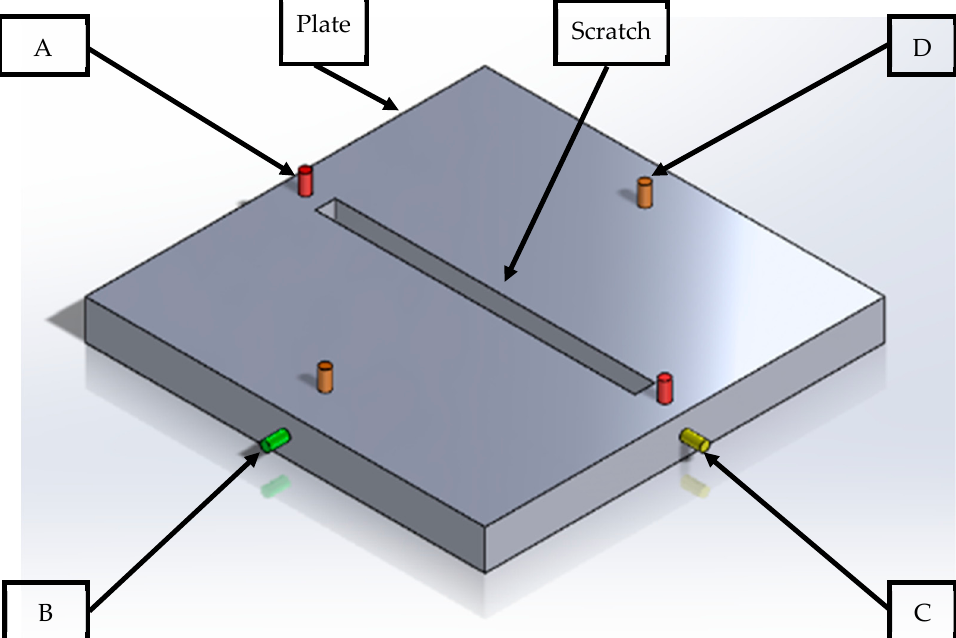
Figure 5. Schematic of test sensor positions. A = on the scratch face parallel to the scratch direction (red markers). B = on the “edge” of the sample perpendicular to the scratch direction (green markers). C = on the “edge” of the sample parallel to the scratch direction (yellow markers). D = on the scratch face perpendicular to the scratch direction (orange markers). Note measurements from orientation D are not used in this work.